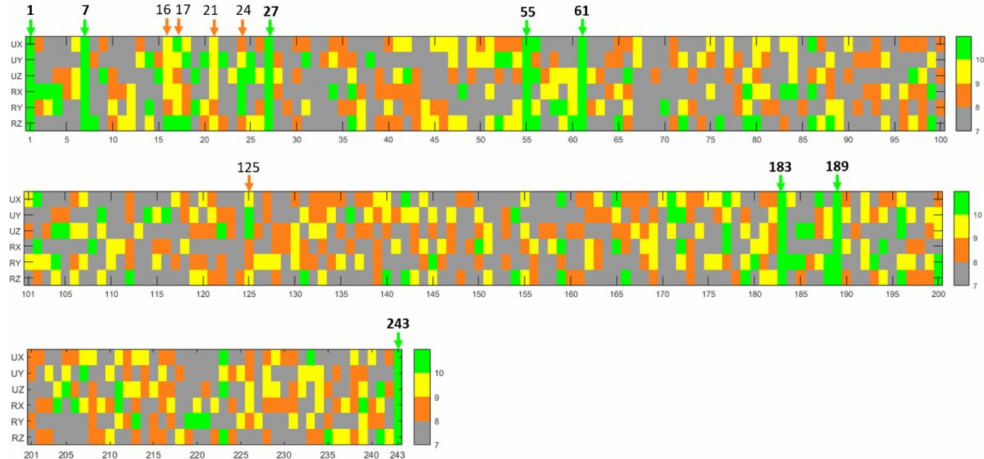
Figure 13. Data frequency graph in the 10 best performance networks for T2. Most used 13 input data are shown.